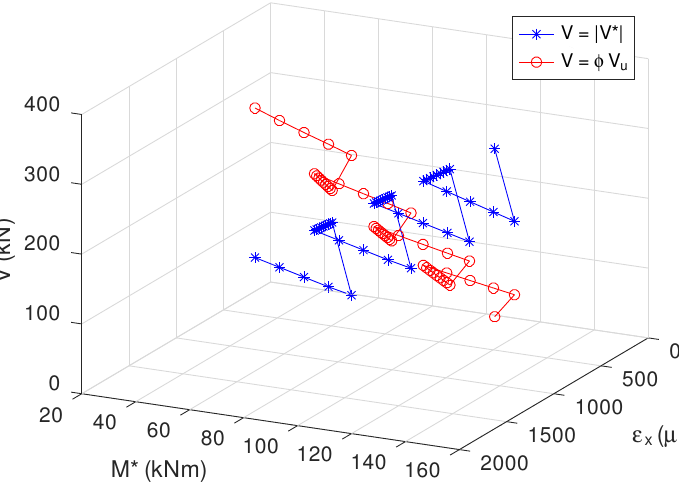
Figure 6. 3D plot for x veh = 16.8 to 20.8 m in steps of 0.1 m.